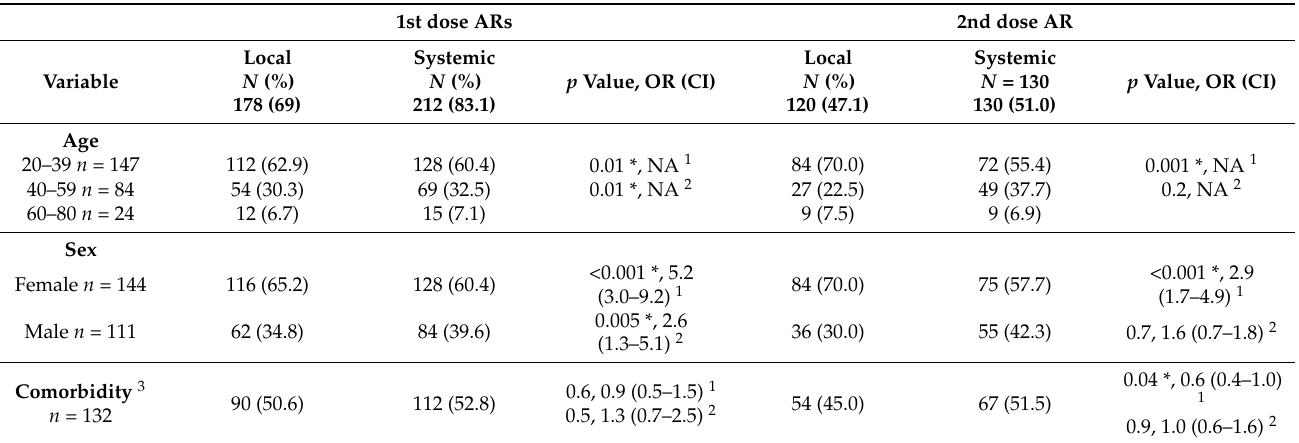
and 0.9, respectively) (Table 2). Table 2. Factors associated with adverse reactions to vaccine. Table 2. Factors associated with adverse reactions to